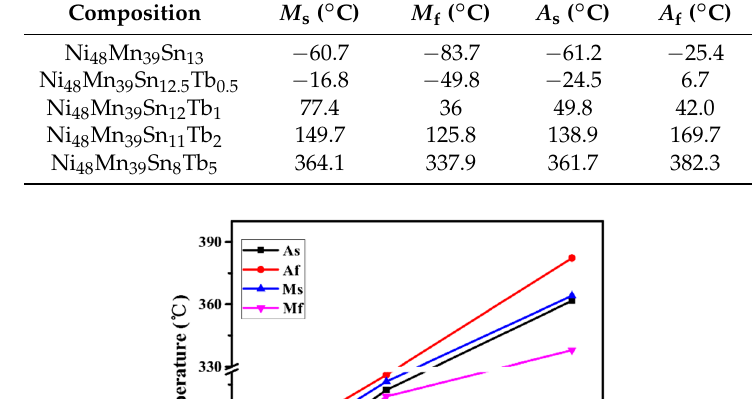
Table 2. The characteristic temperatures of Ni 48 Mn 39 Sn 13 − x Tb x alloys ( x = 0, 0.5, 1, 2, 5 at. %) denoted as M s , M f , A s and A f , respectively.